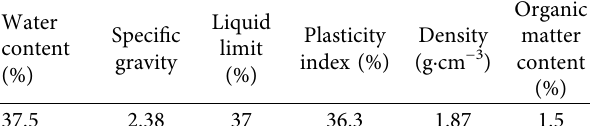
Table 1: Basic mechanical properties of remolded soil.